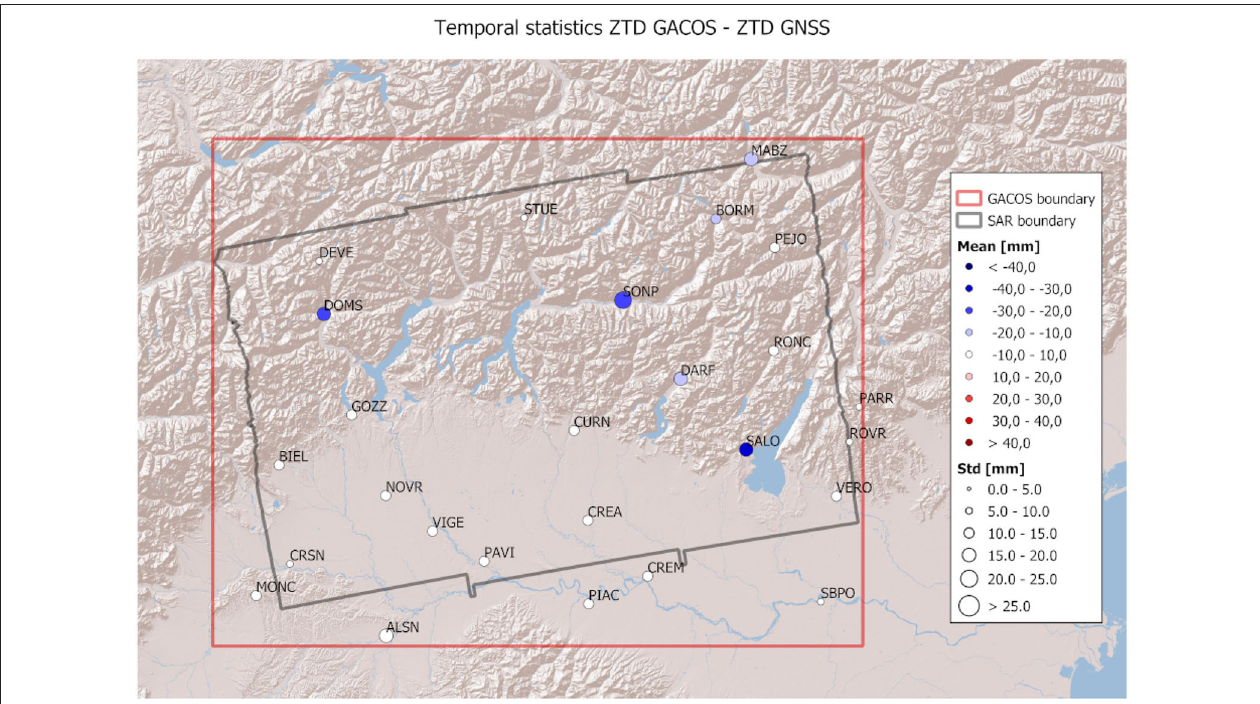
FIGURE 10 | Map of the temporal statistics of the difference between GACOS ZTD and GNSS ZTD. In this figure, GACOS has been taken with its original spatial resolution and for all 46